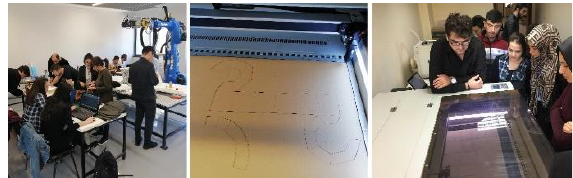
Figure 11. Working with digital fabrication tools at KTU CODE FAB (Photos by the author)